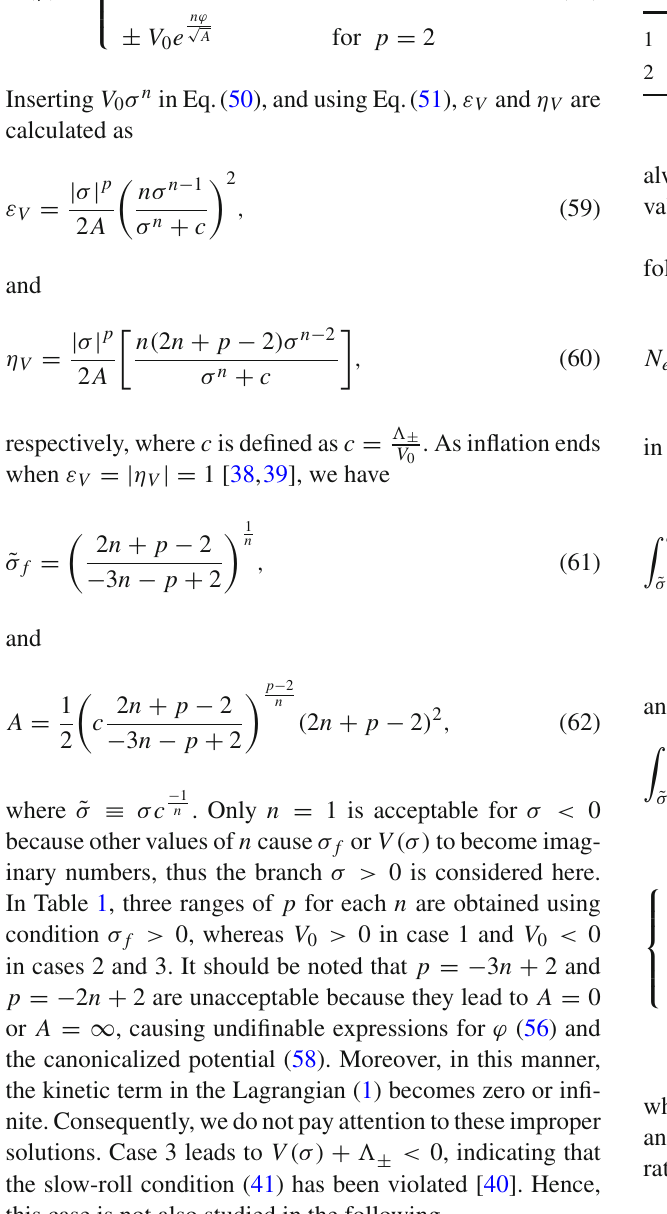
Table 2 The ranges of n which lead to p > 0 and thus pole Case Range i Range